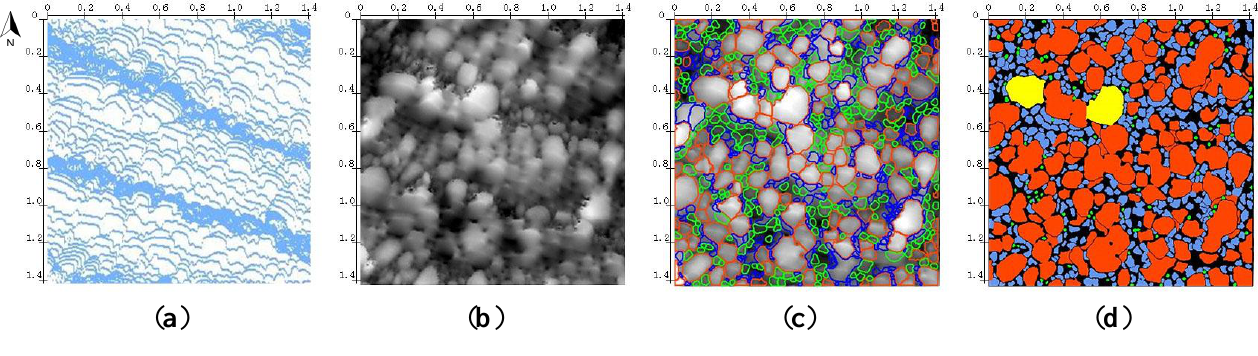
Figure 9. ( a ) MLS points. ( b ) DSM. ( c ) Boundaries of individual particles with the DSM in the background; Red, blue and green corresponding to the results of the first, second and third iteration. ( d ) 2D map of individual sediment particles: boulder (yellow), cobble (red), coarse gravel (blue), medium gravel (green), and non-segmented area (black). The scalar unit in (a–d) is in m, and the coordinates of the origin point in (a–d) is